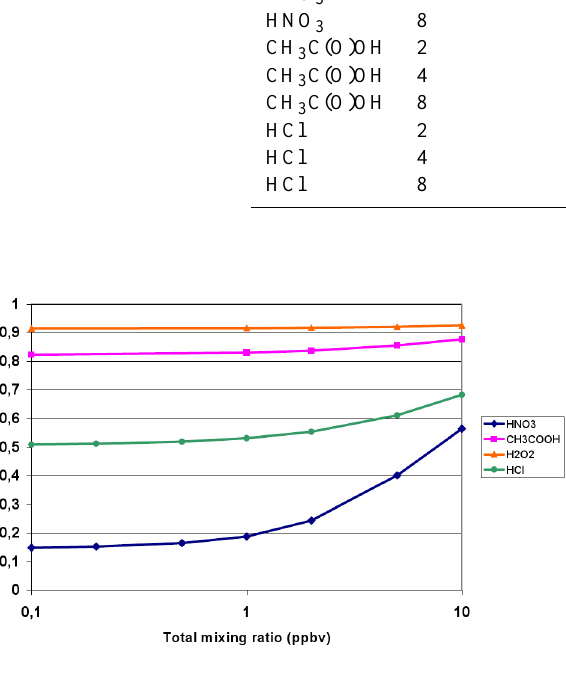
Fig. 11. Ratio of the mean gas phase mixing ratio on the to- tal mixing ratio as a function of the total mixing ratio of HNO 3 , CH 3 C(O)OH, H 2 O 2 and HCl. The total mixing ratio is defined as the sum of the gas phase mixing ratio and of the gas mixing ratio on the ice surface. For H 2 O 2 the partition coefficient measured by MPIC is